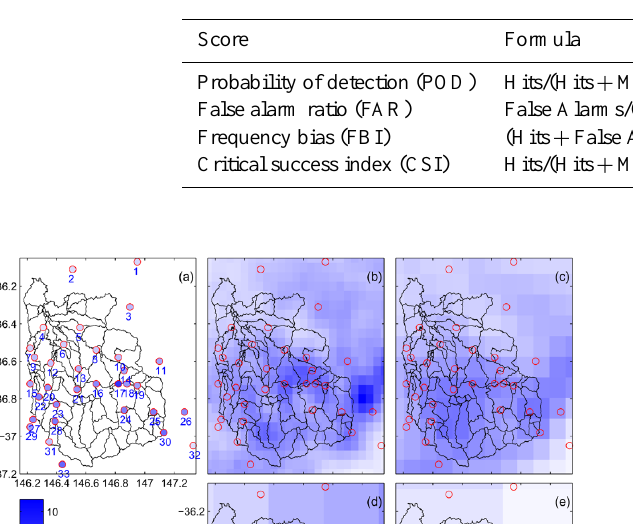
Table 4. Categorical verification scores used in the study.